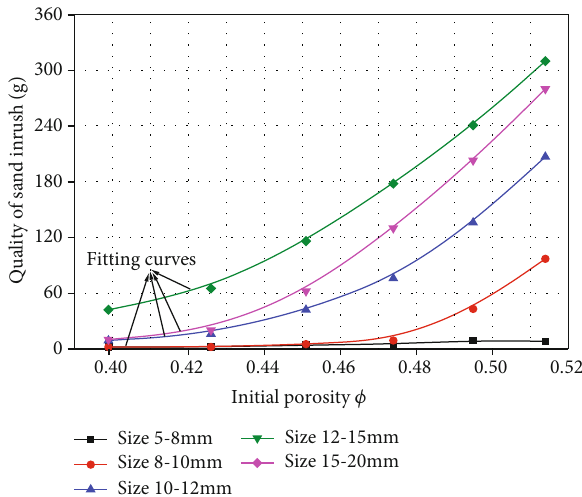
Figure 8: The curve of relationship between the quality of sand inrush and initial porosity of broken rock